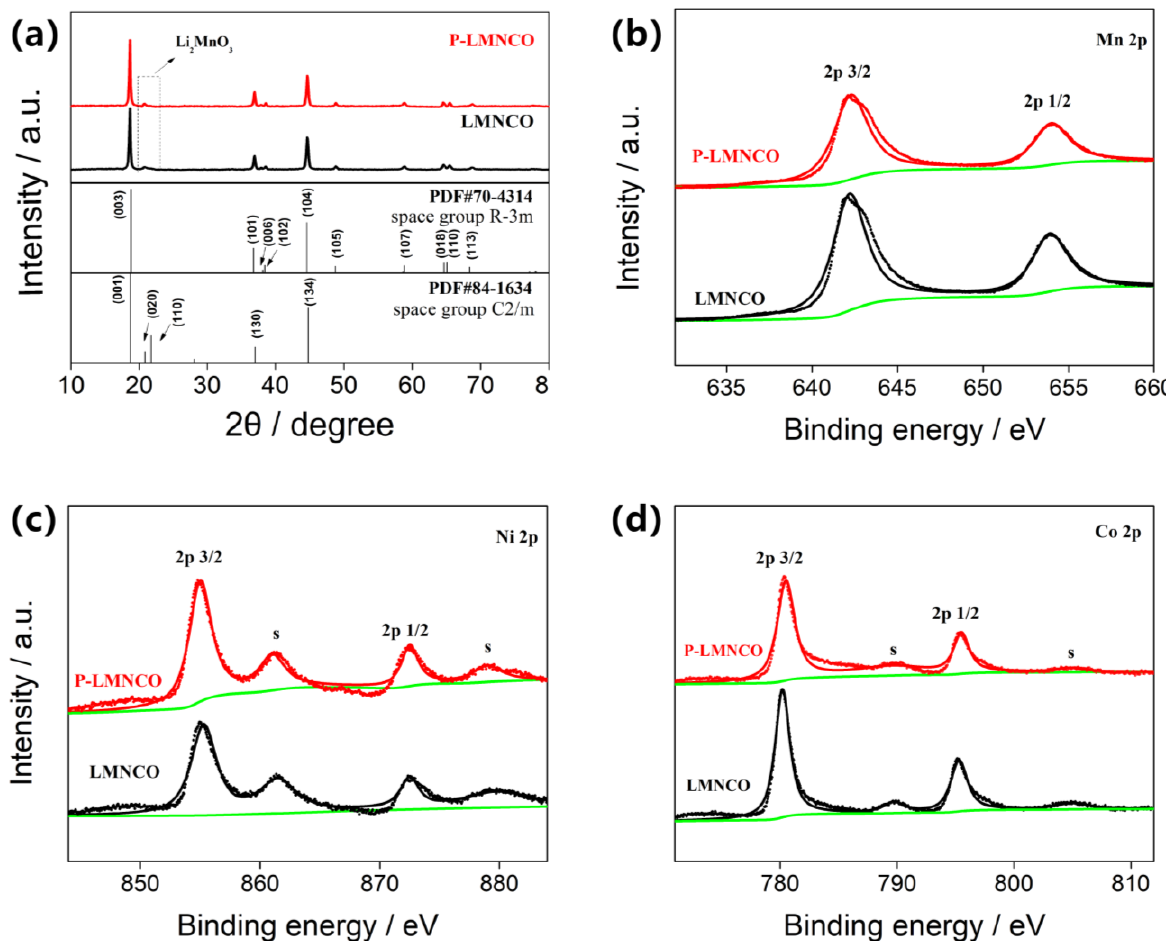
Figure 2. ( a ) The XRD patterns of LMNCO and P-LMNCO. XPS spectra of ( b ) Mn 2p, ( c ) Ni 2p and ( d ) Co 2p of LMNCO and P-LMNCO.